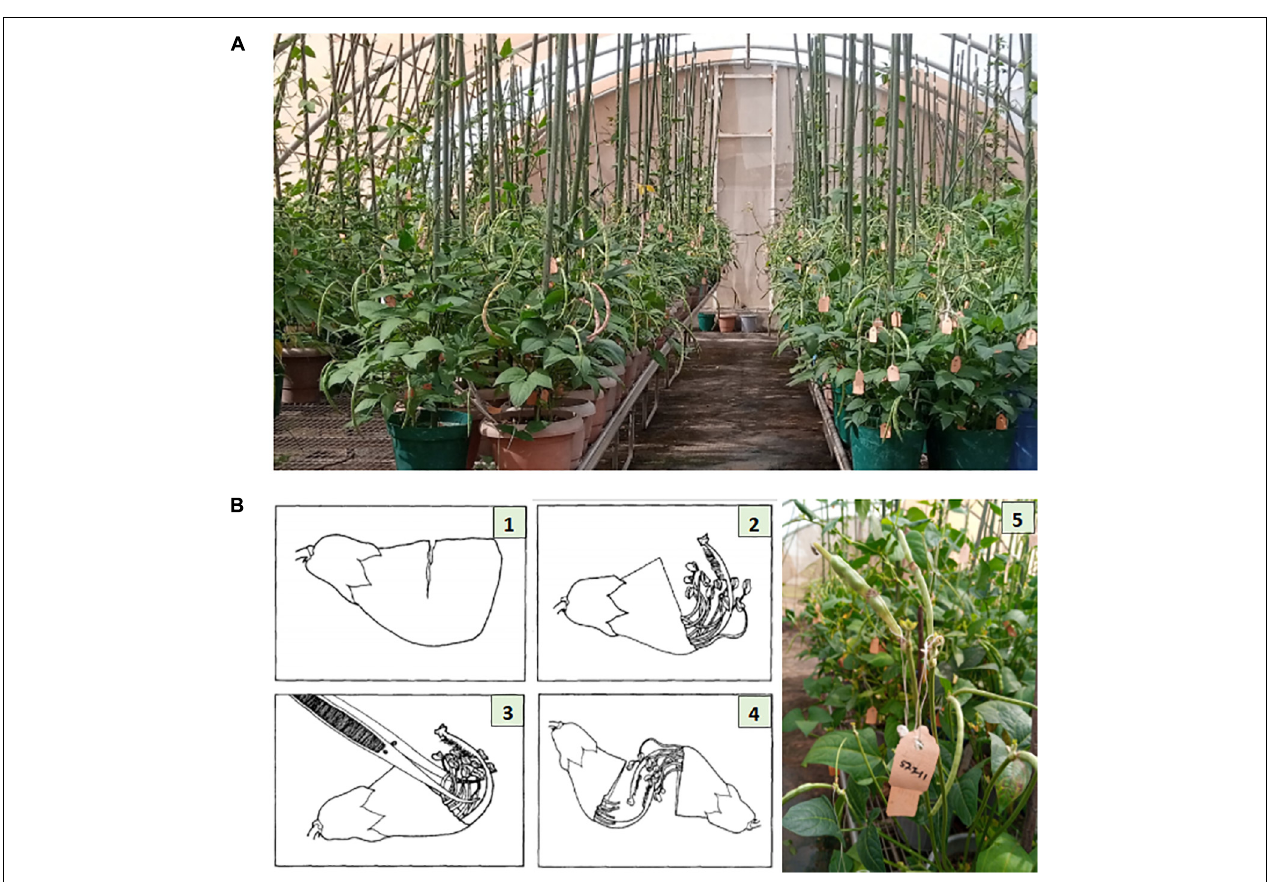
FIGURE 1 | Illustration of cowpea crossing procedure. Panel (A) shows the cowpea crossing block with genotypes growing in pots placed on crossing benches in a screen house at IITA research station, Kano Nigeria. Panel (B) depicts the crossing steps: (1) Cut about two-thirds the width of the unopened bud. (2) Gently tear off the cut segment exposing the anther sacs. (3) Remove all anther sacs with forceps. (4) Pollinate the emasculated bud. (5) Fix a tag beneath the pollinated bud, listing the cross and the date of pollination. Photo source: Illustration 1–4 is adopted from Myers (1996), Photo (A,B) -5 were taken from IITA cowpea crossing block, Kano